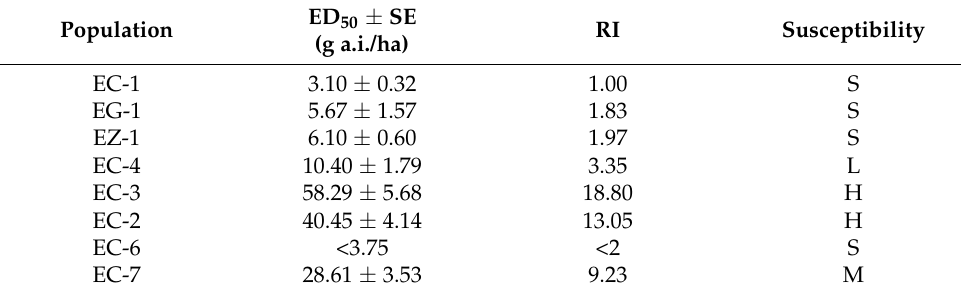
Table 4. The susceptibility of different E. spp. to penoxsulam.